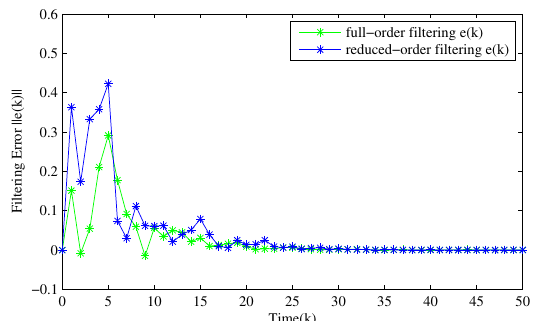
Figure 5. Evolution of full- and reduced-order filtering e ( k ) .